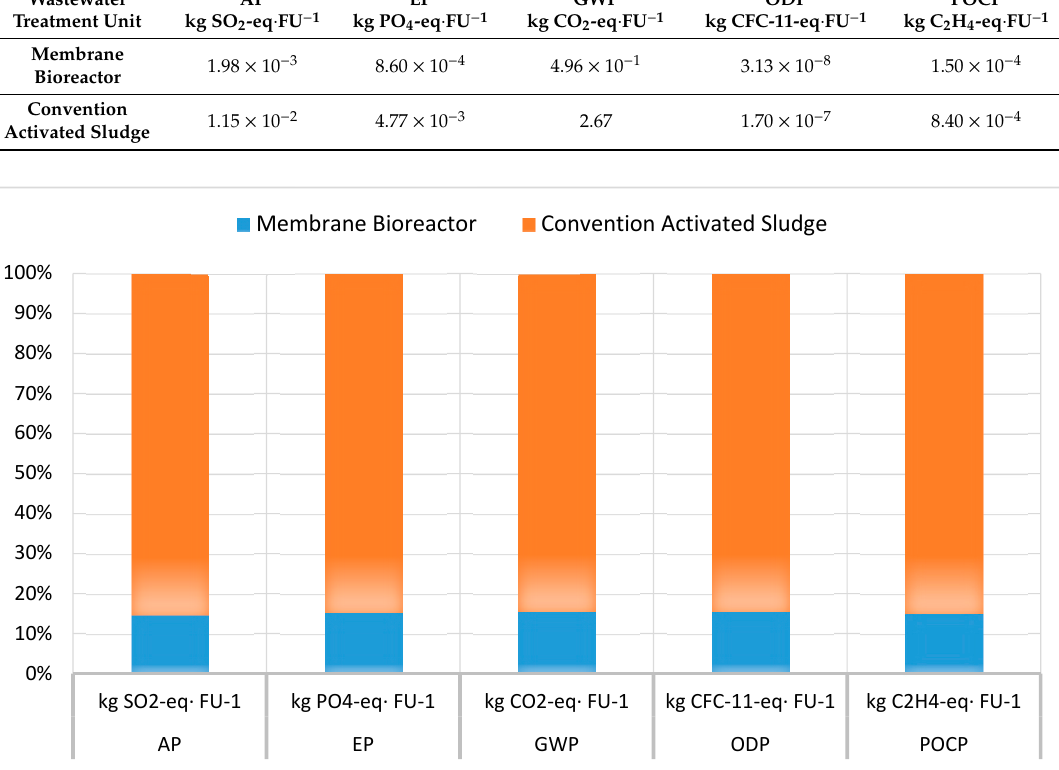
Figure 6. Comparison of LCIA for the two units with no sludge removal contribution.